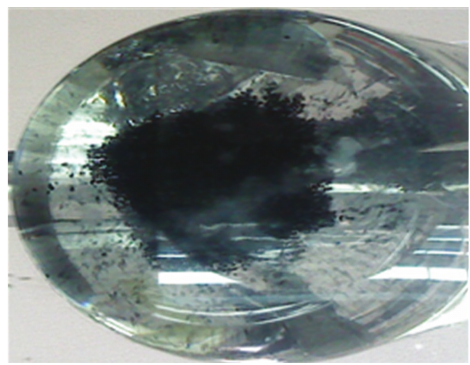
Figure 10: Particle distribution by 6CB.